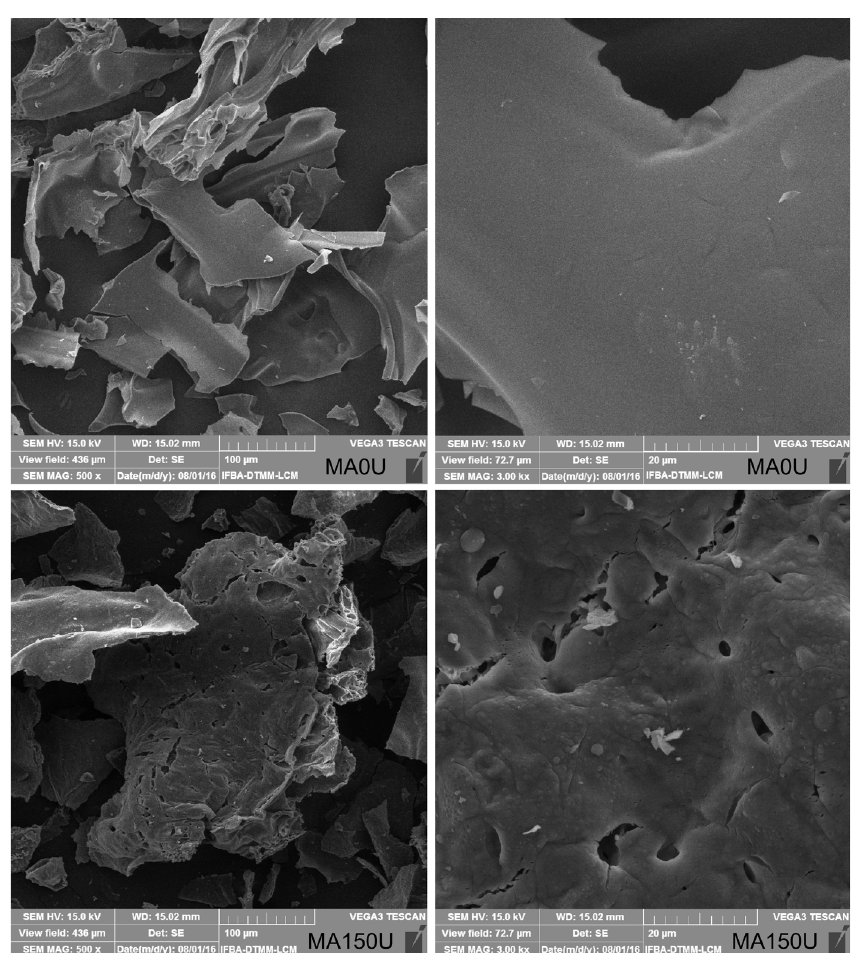
Figure 5. SEM images of the MA0U and MA150U samples, with different